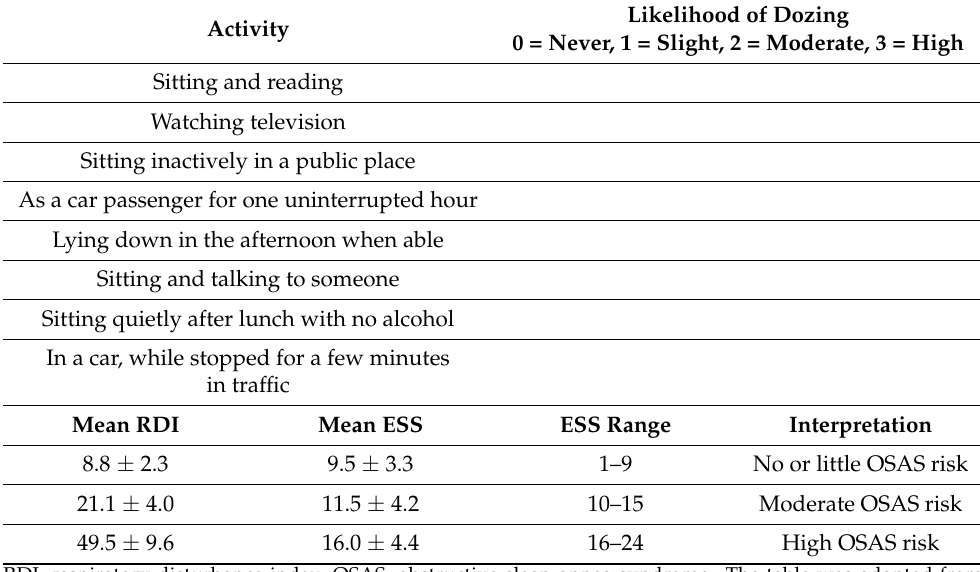
Table 2. The Epworth Sleepiness Scale (ESS) and its relationship to OSAS risk. Each question is scored from 0 to 3. ESS score range is from